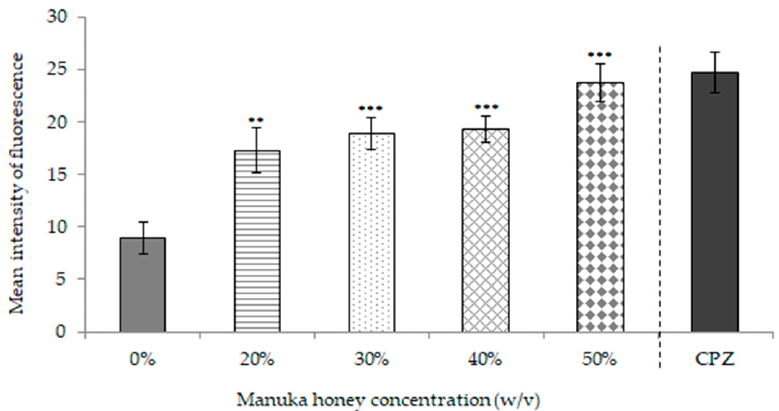
Figure 5. Effect of MkH on E. coli AG100 TET efflux pump activity evaluated using ethidium bromide staining. Chlorpromazine (CPZ) was used as efflux pump inhibitor.